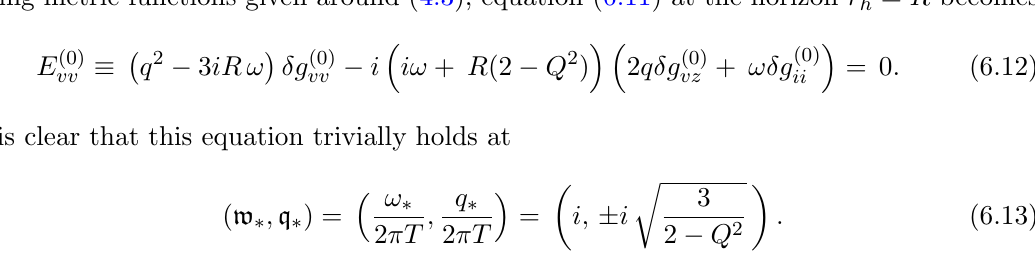
Figure 14. Left panel: three branches of Puiseux series at purely imaginary momenta, associated with Q = 0 : 4 in spin 0 channel. Obviously the points (6.14) lie on the sound branches, manifest- ing the hydrodynamic origin of quantum chaos. Right panel: comparison between the left panel dispersion relations with those of associated with a AdS 5 Schwarzschild black brane ( Q = 0). Using metric functions given around (4.3), equation (6.11) at the horizon r